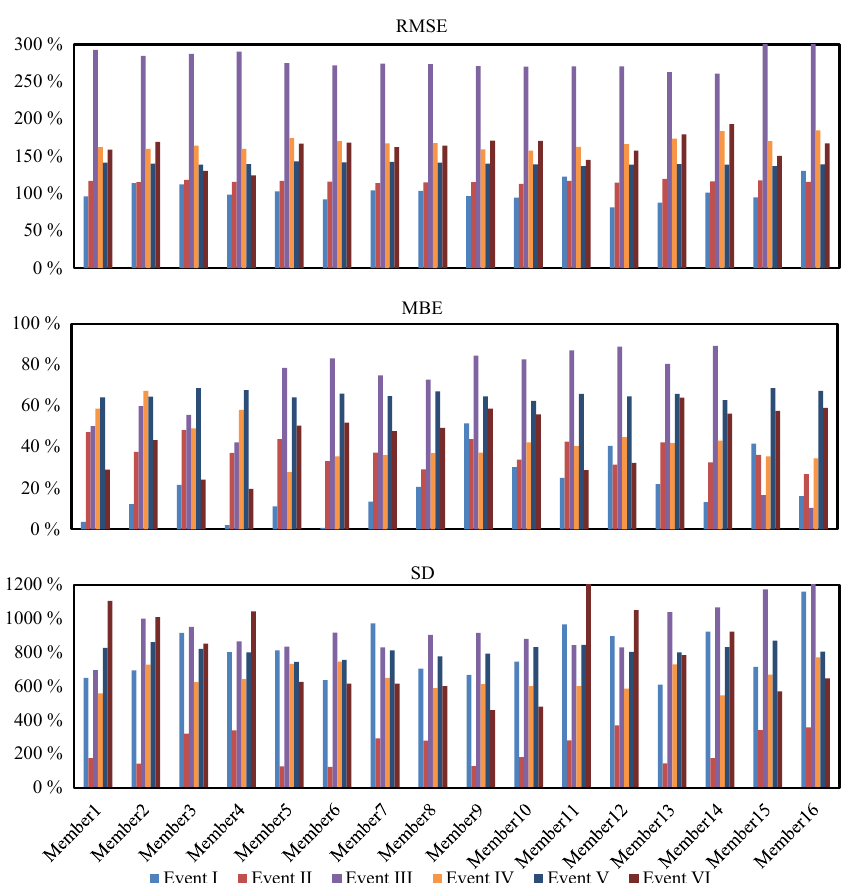
Figure 8. Temporal values of the three continuous indices for different storm events with the 16 members of the physical